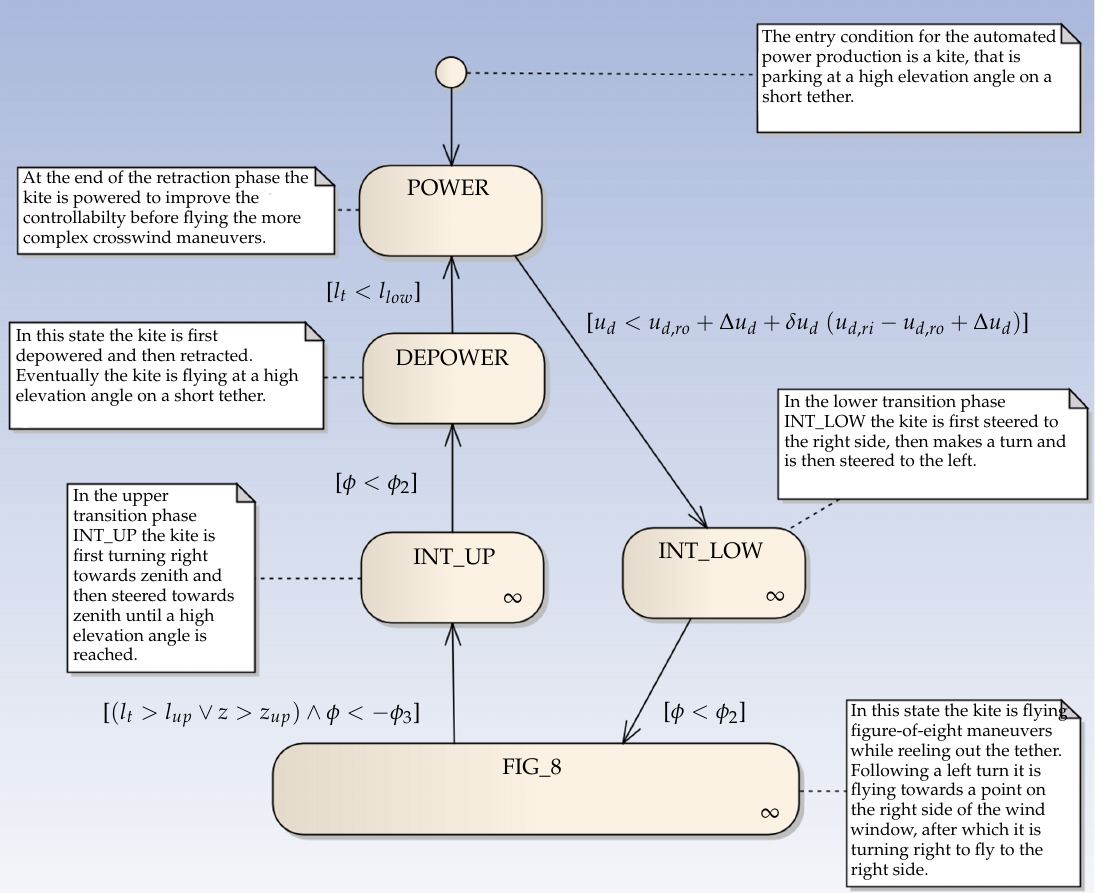
Figure 5. Finite state diagram for the states of the high-level controller for fully automated power production. Table 1. Finite substates of the figure-of-eight flight path planner [28]. Set value P SE used only when the proportional-integral-derivative (PID) controller is active. Set value ˙ χ set for the turn rate is used only when the PID is